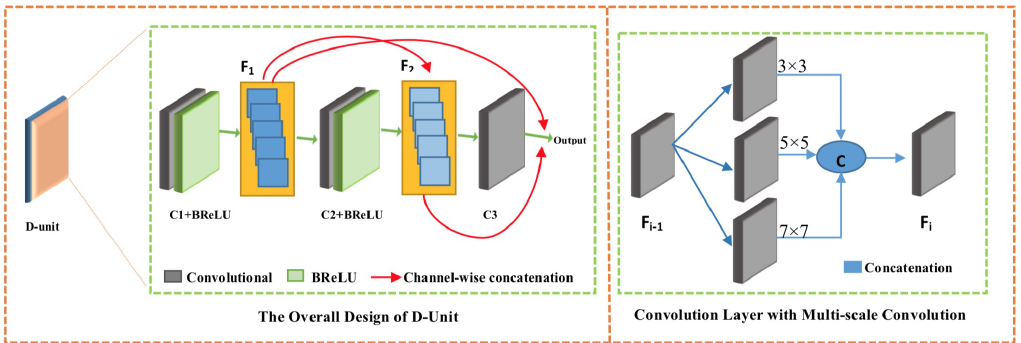
Figure 8. Internal Structure of Both D-unit and MCNN: (left) D-unit; and (right)